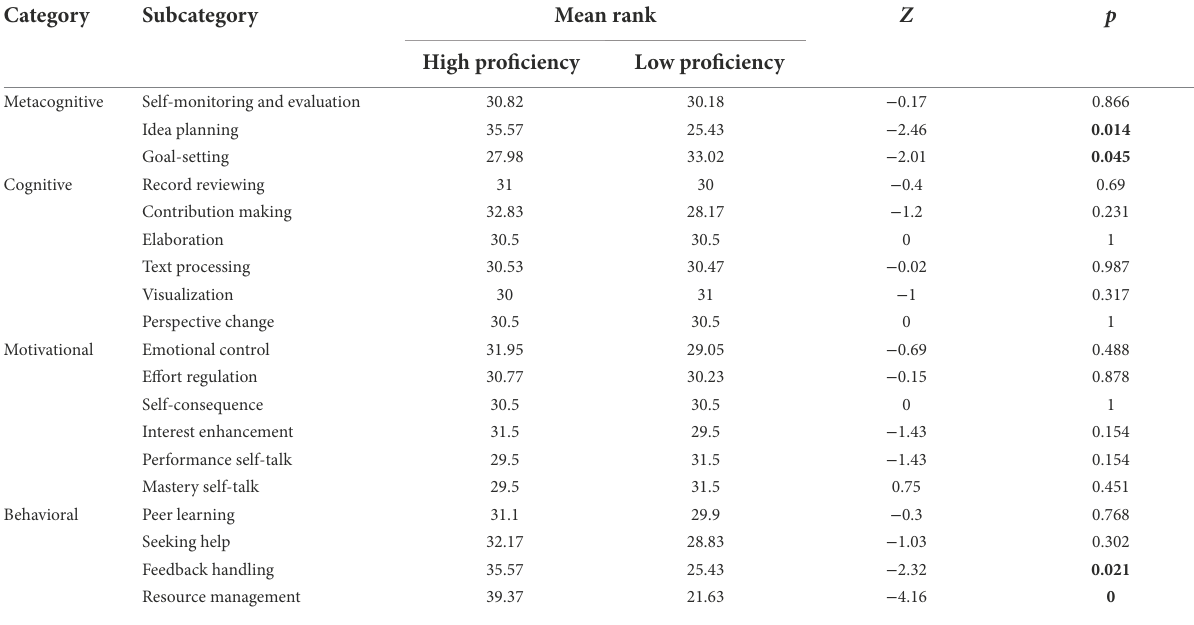
TABLE 6 Results of Mann–Whitney U tests regarding the use of self-regulated writing strategies identified in reflective journals by high- and low- proficiency groups.